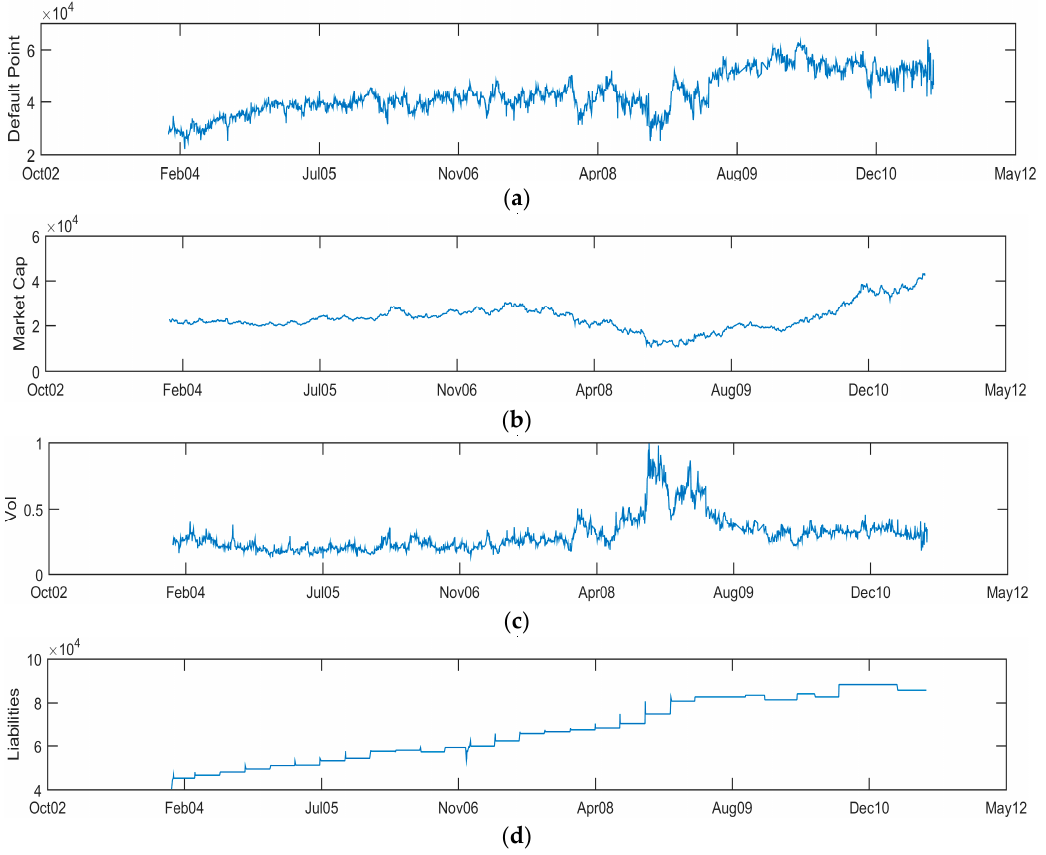
Figure 3. BMW time series for: (a) the default barrier; (b) market capitalization; (c) 10-delta put implied volatility; (d) liabilities. (a,b,d) are in EUR millions.